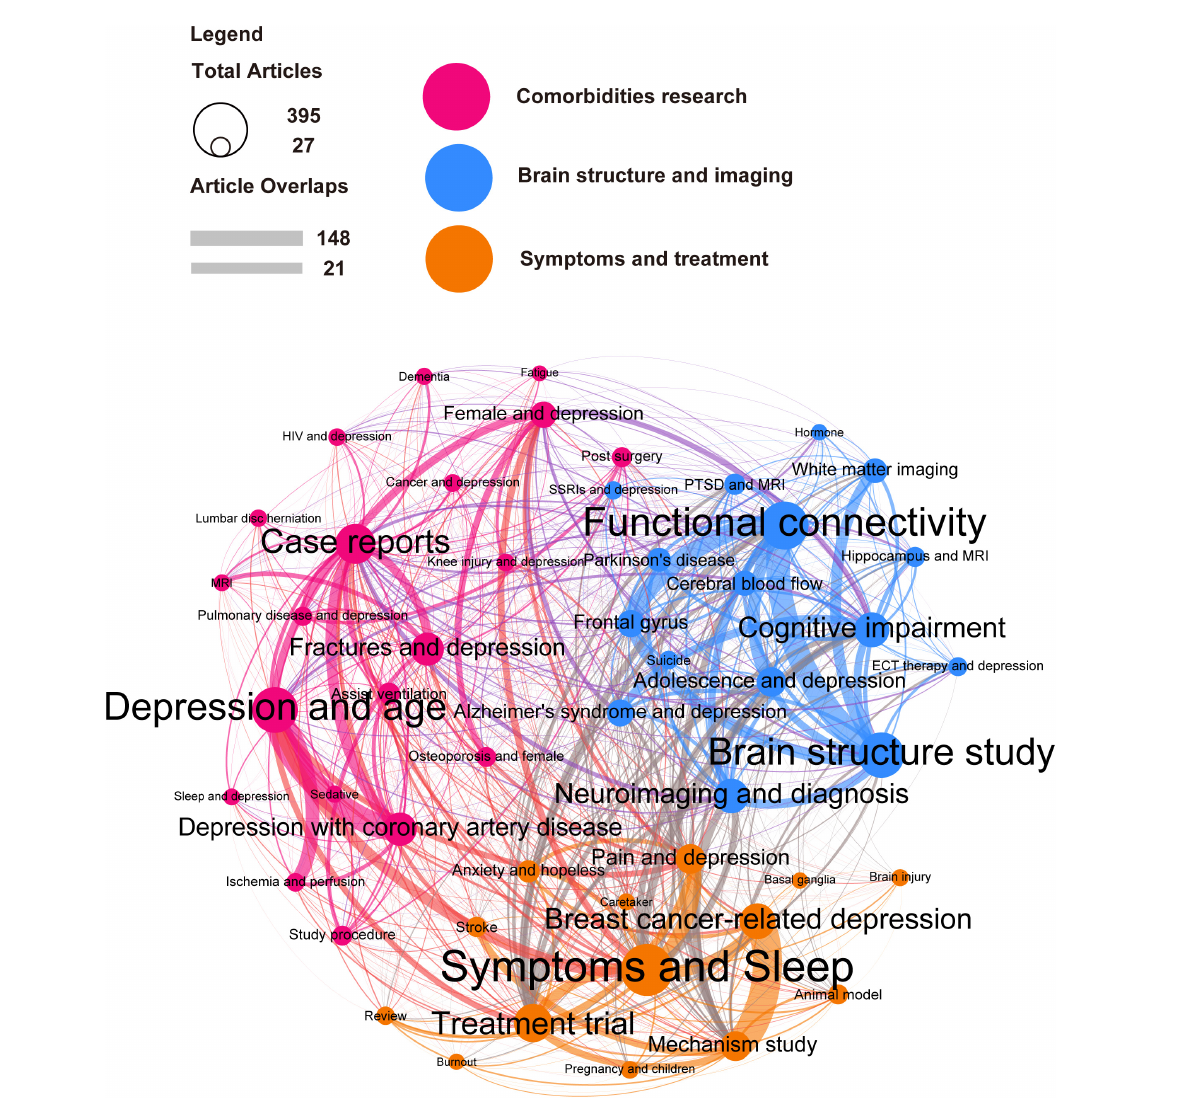
FIGURE5 Latent Dirichlet allocation (LDA) identified the main areas of depression and radiology are “Symptoms and Treatment,” ”Brain Structure and Imaging,” and ”Comorbidities research.” The LDA algorithm was used to analyze publications from the last 20 years. from which 50 topics were identified and classified into three broad categories: “Symptoms and Treatment” (orange), ”Brain Structure and Imaging” (blue), and ”Comorbidities research” (rose-red). The circle size represents the number of publications contained in the research topic. For example, the algorithm found that the topic “Depression and age” contains 395 publications. The line thickness between the circles represents the degree of overlap between the two research topics, such as the 148 publications with the highest overlap in “Breast cancer-related depression” and “Mechanism